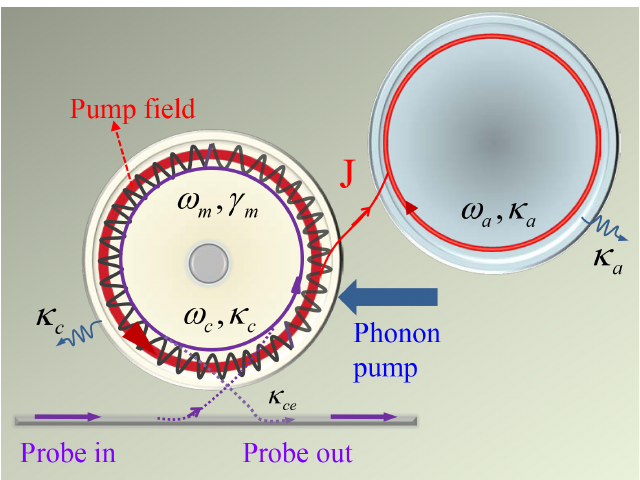
Figure 1. Schematic diagram of the photonic-molecule optomechanics with phonon driving, where an optomechanical cavity c driven by two-tone fields coupled to an auxiliary cavity a with high quality